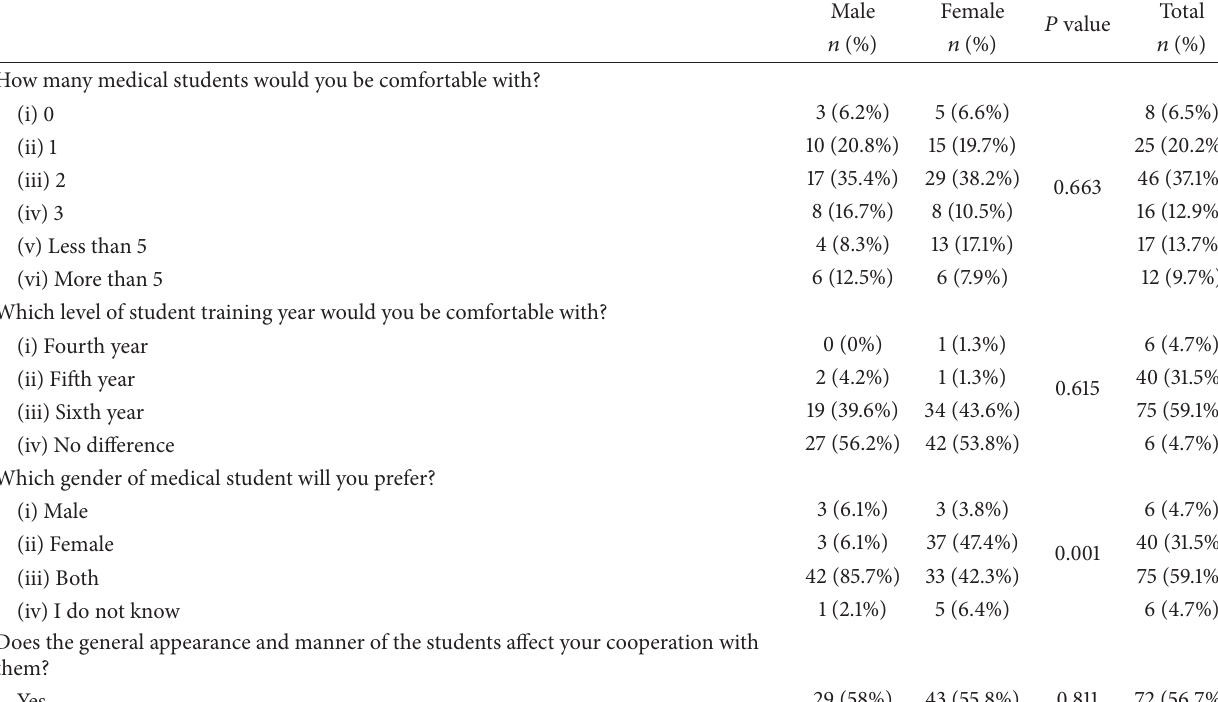
Table 5: Patients comfort level toward the number, gender, and medical training year of the medical students.